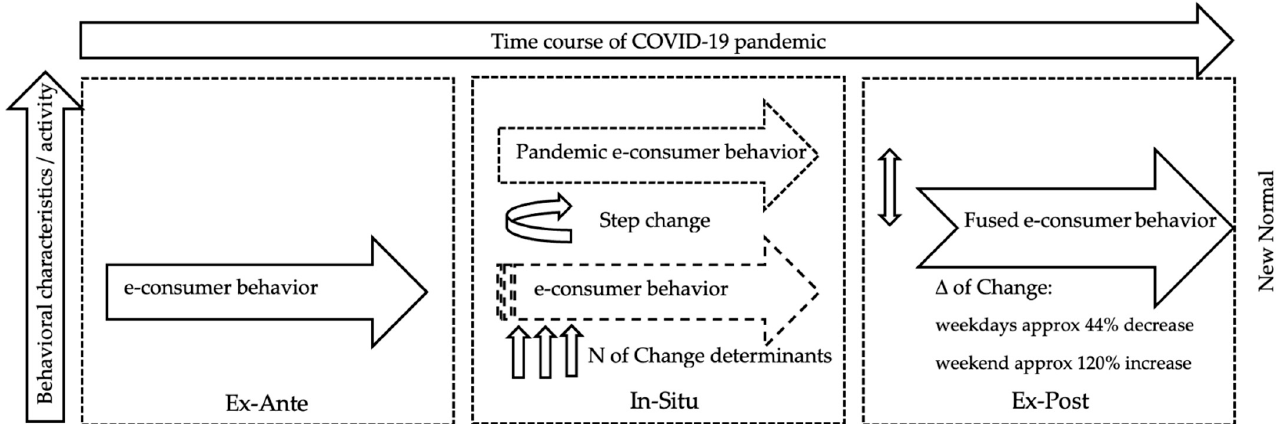
13 of 20 Figure 10. Engagement ratio and its components over individual observation periods: ( a ) working days; ( b ) weekends. Based on the presented findings, the research task can be considered to be solved. The individual partial analyses described in Sections 4.1–4.4 provided the answer to the research question. Considering the comparison of the trend levels, significant changes